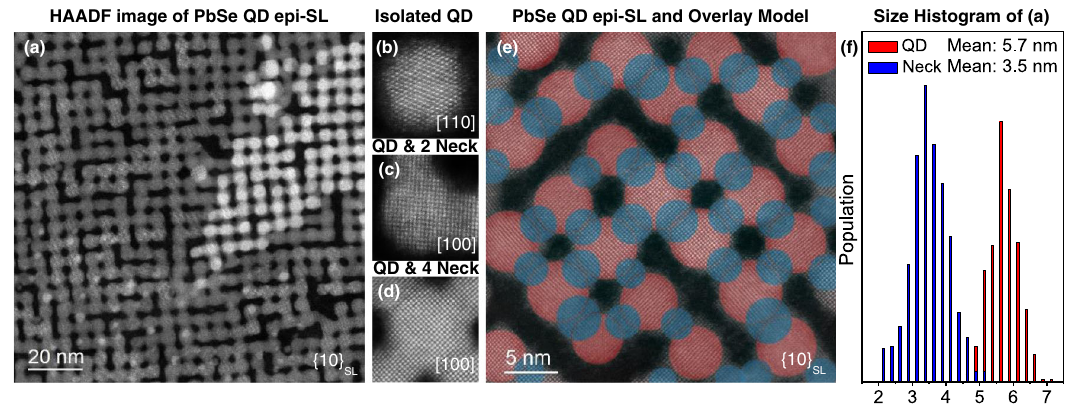
Fig. 1 | Structural analysis of the monolayer PbSe QD epi-SL. a HAADF-STEM image of an epi-SL showing various structural defects, including missing QDs and necks. b – d Atomic-resolution HAADF reference images of ( b ) an iso-QD, ( c ) a QD withtwonecks,and( d )aQDwithfournecks,demonstratingthecrystallinityofthe